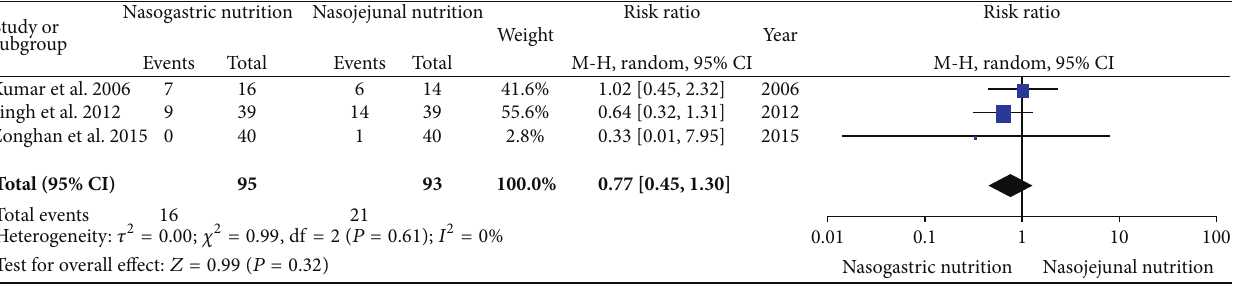
Figure 4: Comparison of the infectious complications between the NG and NJ nutrition groups.